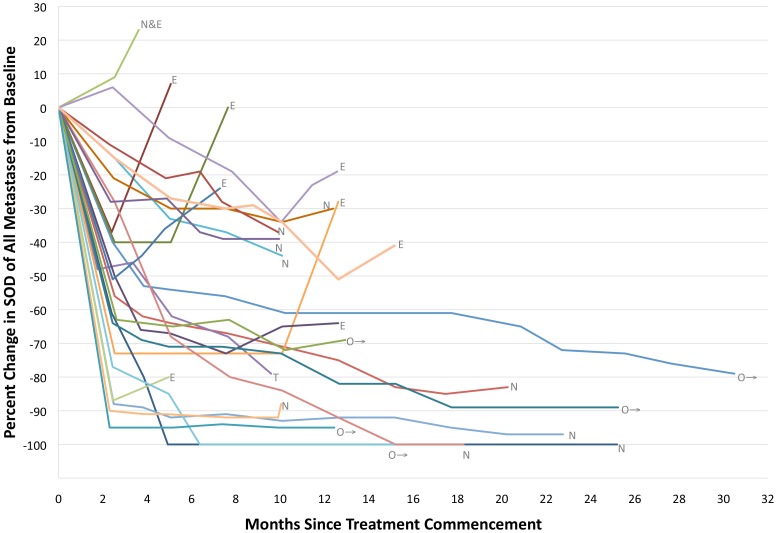
Inter-patient heterogeneneity of response and progression with CombiDT.Plot of the percent change in the sum of diameters of all metastases ≥5 mm within an individual patient compared to baseline at various time points during treatment with CombiDT until disease progression. Each line represents an individual patient. Abbreviations: E, disease progressing due to existing lesions; N, new lesions; N+E, new and existing lesions; O→, ongoing response without progression; T, treatment ceased due to toxicity.